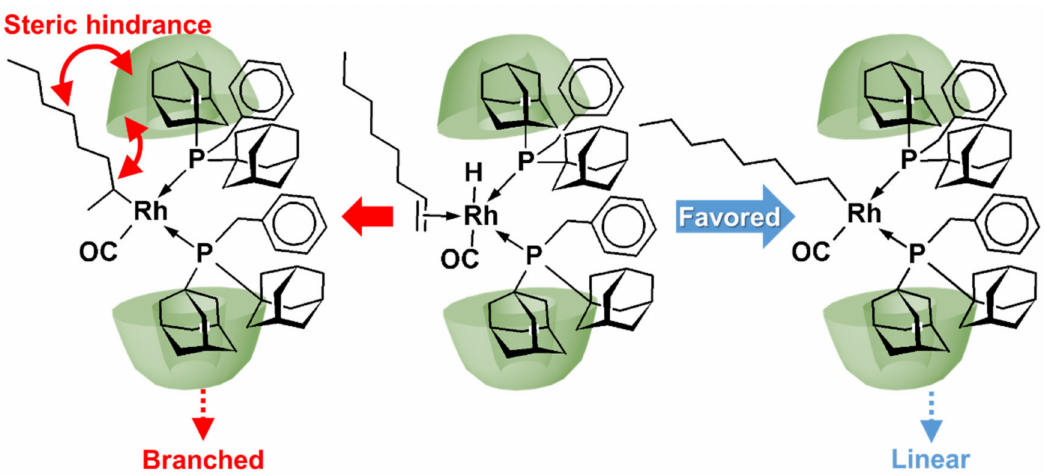
Figure 14. Supramolecular CD-based phosphorus as a first- and second-sphere ligand of